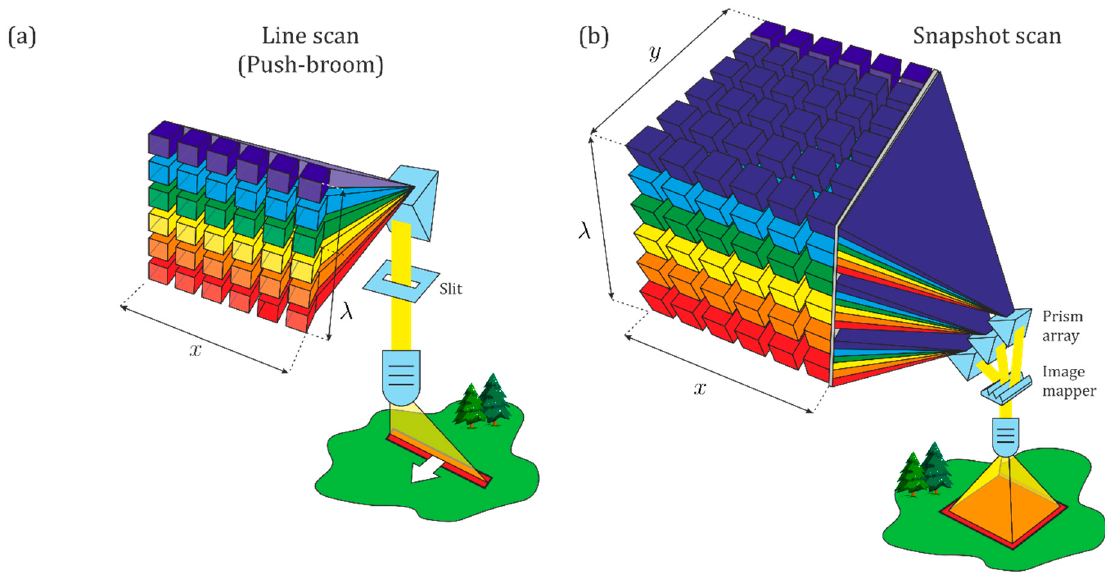
Figure 2. Portions of the data cube collected during a single detector integration period for ( a ) push-broom: spatial dimension (y-line), spectral dimension ( λ ) and ( b ) snapshot devices: spatial dimension (x, y), spectral dimension ( λ ) (adapted from Jurado et al. [25]).